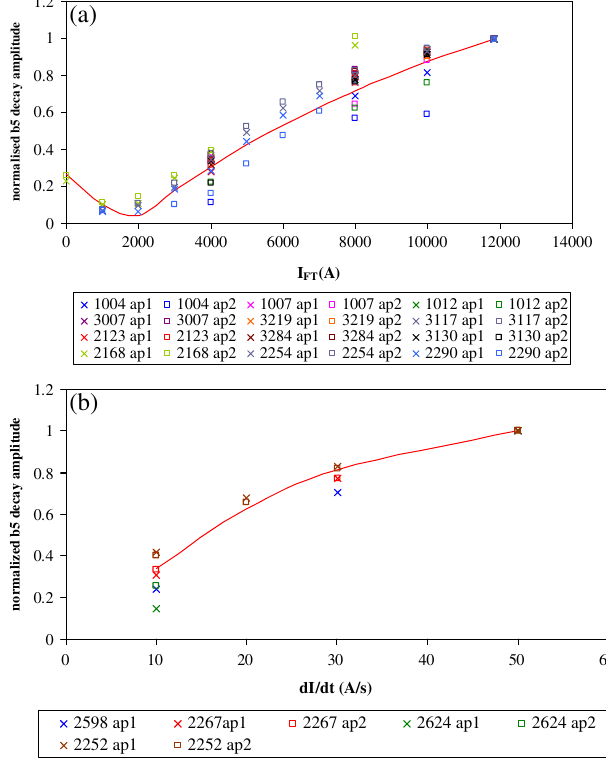
FIG. 7. (Color) (a) The normalized b 5 decay amplitude and the FiDeL model in red vs the precycle flattop current. (b) The normalized b 5 decay amplitude and the FiDeL model in red vs the precycle ramp rate. Note: The labeling in the key denotes the magnet number and aperture. The decay amplitude is normalized to I max ¼ 11 850 A . I FT ¼ 0 denotes no precycle, i.e., a cycle directly after a quench.